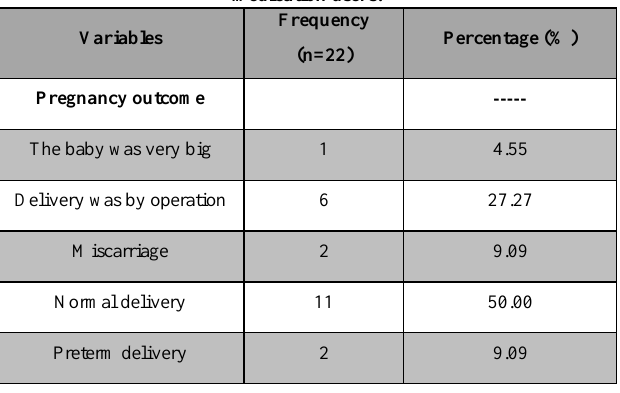
Table 4. Distribution of pregnancy outcome among the Herbal medication users.